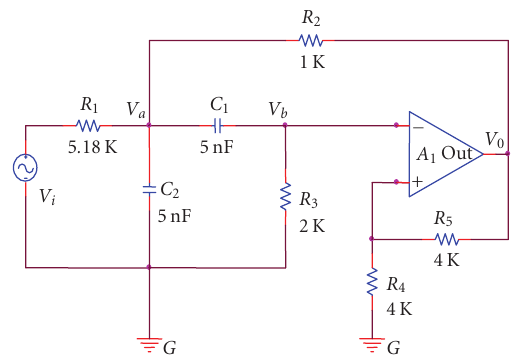
Figure 4: Sallen-key bandpass filter circuit.